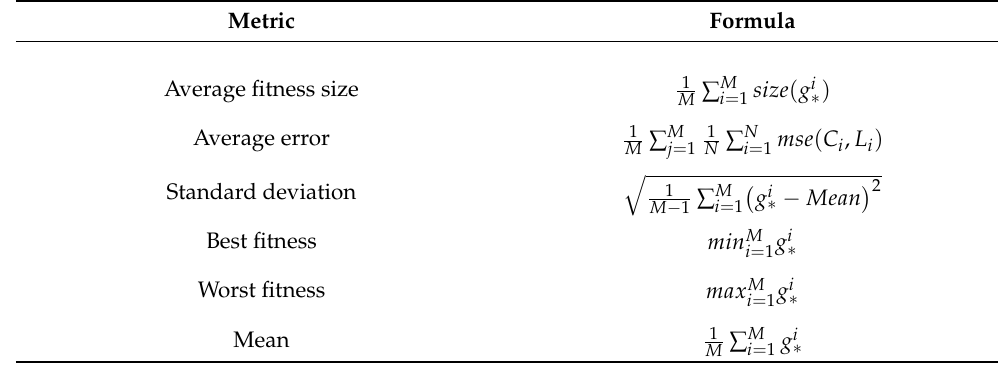
Table 4. Evaluation metrics used in assessing the feature selection approach.